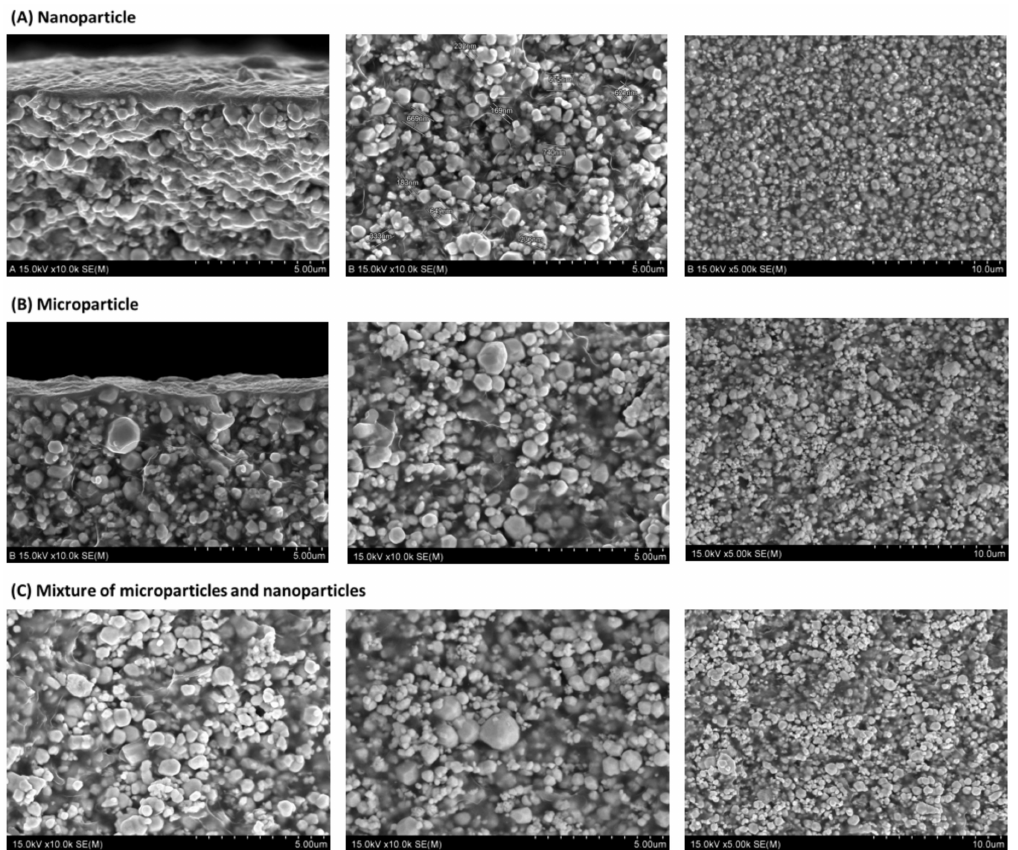
Figure 4. Structure of inner particle arrangement of shielding sheet. ( A ) Nanoparticle shielding sheet; ( B ) microparticle shielding sheet; ( C ) nano-micro particle mix